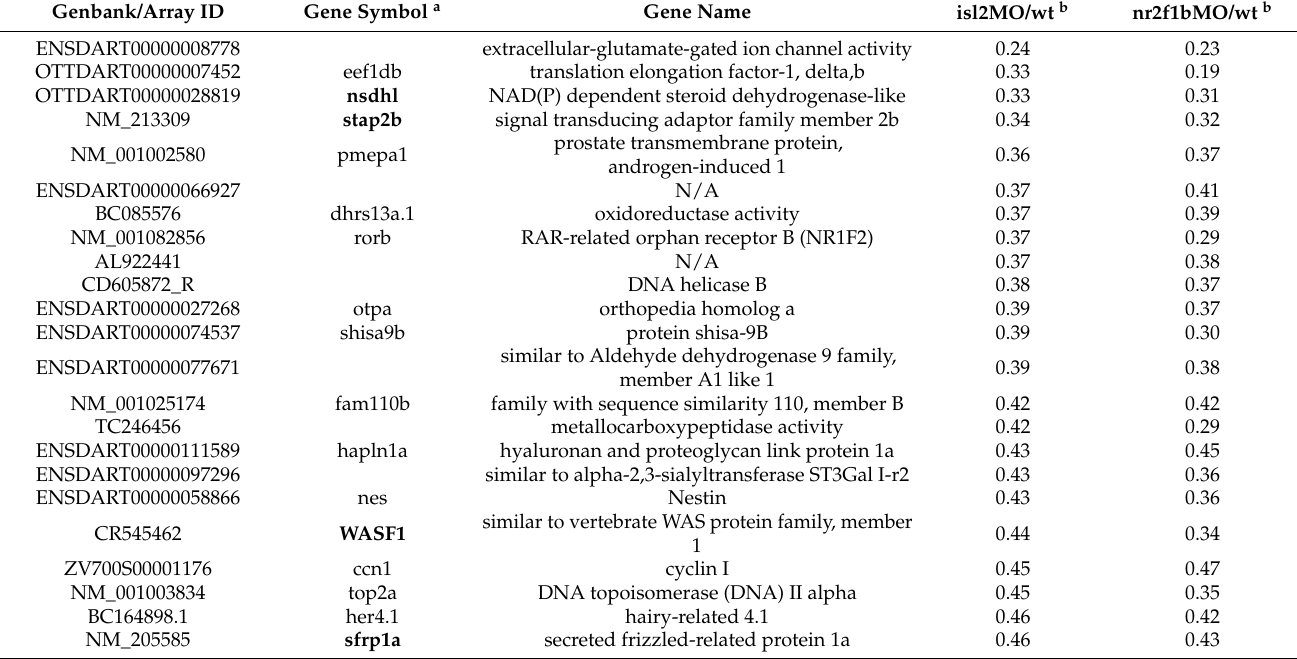
Table 2. Genes down-regulated ≥ 2-fold in both isl2 MO and nr2f1b